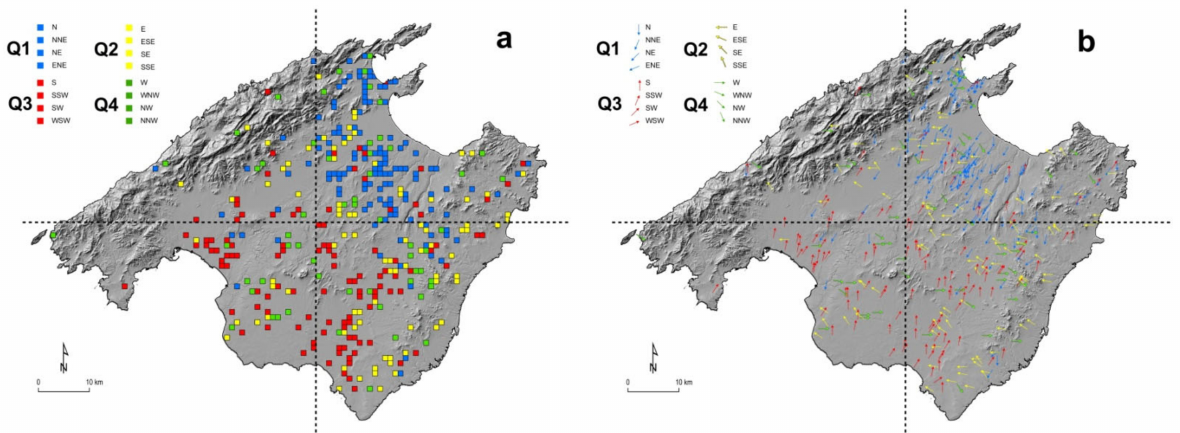
Figure 13. ‘Anemographic’ sea-breeze direction model based on the experimental threshing floors, on a digital elevation model (DEM). On the left ( a ), raster model: colored pixels indicate the proxy-wind-direction (and quadrant Q ) at each site; On the right ( b ), vector model: colored arrows indicate the proxy-wind-direction (and quadrant Q ) at each